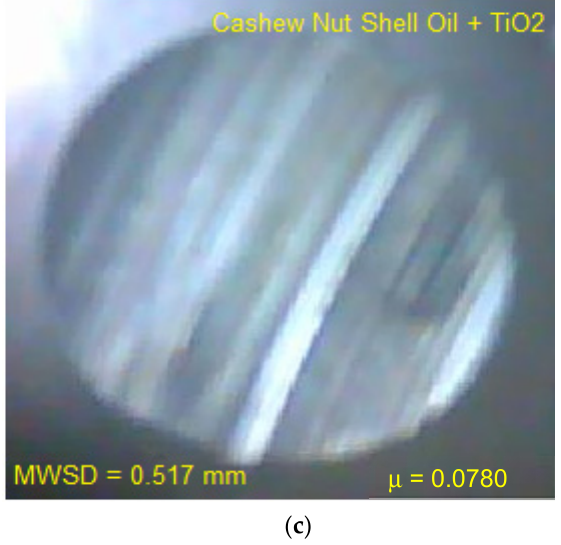
Figure 2. ( a ) Four-ball wear test for SAE20W40. ( b ) Four-ball wear test for veg oil. ( c ) Four-ball wear test for veg oil + TiO 2 . Table 2. Properties of lubricants used.